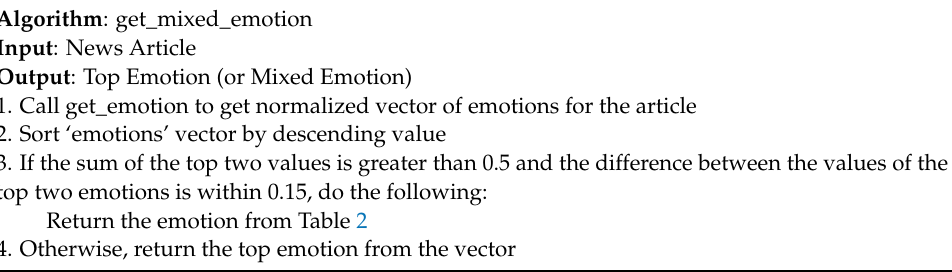
Algorithm 2 Obtain the top emotion or mixed emotion from Plutchik emotion mixing Algorithm :